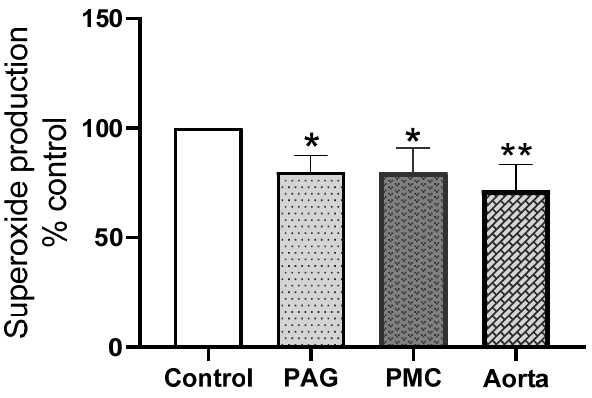
Figure 8. Effect of GSK2795039 on superoxide production in PAG, PMC, and aorta. GSK2795039 significantly reduced NADPH-dependent superoxide production in PAG and PMC, comparable to that in the aorta. Note: the level of superoxide without the inhibitor in each tissue was taken as 100%. * p < 0.05 vs. control, PAG, n = 10; PMC, n = 6; ** p < 0.01 vs. control, aorta, n = 6. GSK2795039 concentration: 25 µM.